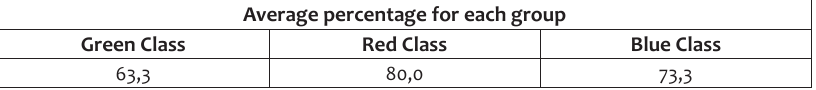
Table 3: Children’s ability to classify and describe.